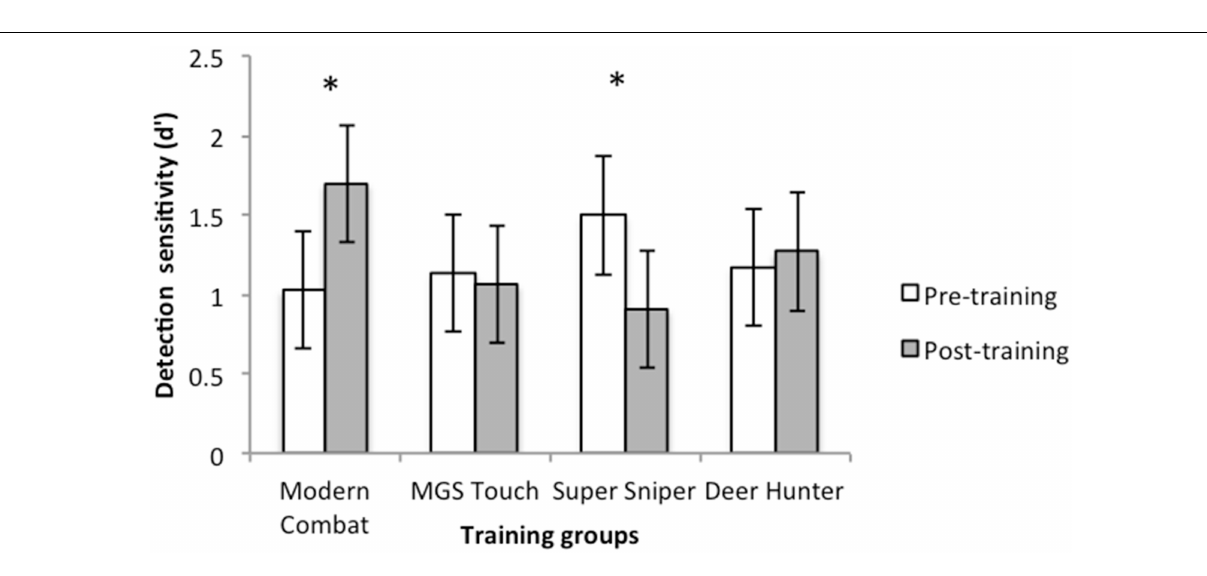
FIGURE 3 | Detection sensitivity ( d (cid:2) ) for 8 target 0 distractor condition from pre to post-training for each training group. Asterisk denote statistical significant change at p < 0.05. Error bars denote 95%